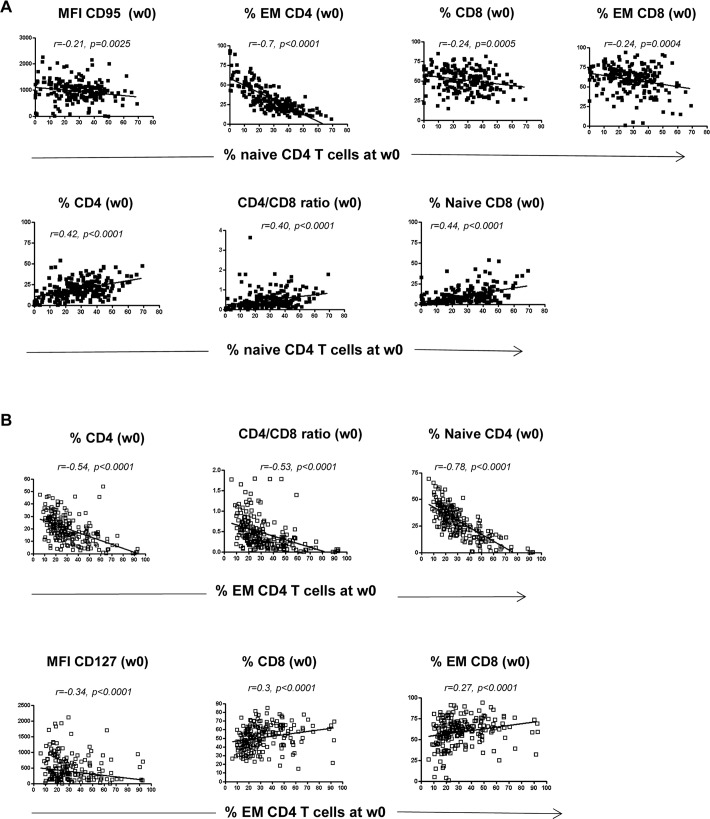
Baseline frequency (w0) of Naive CD4 T cells (A) and EM CD4 T cells (B) correlates with several baseline immune parameters. The correlation analysis was performed by Spearman test and a p<0.05 was considered significant.